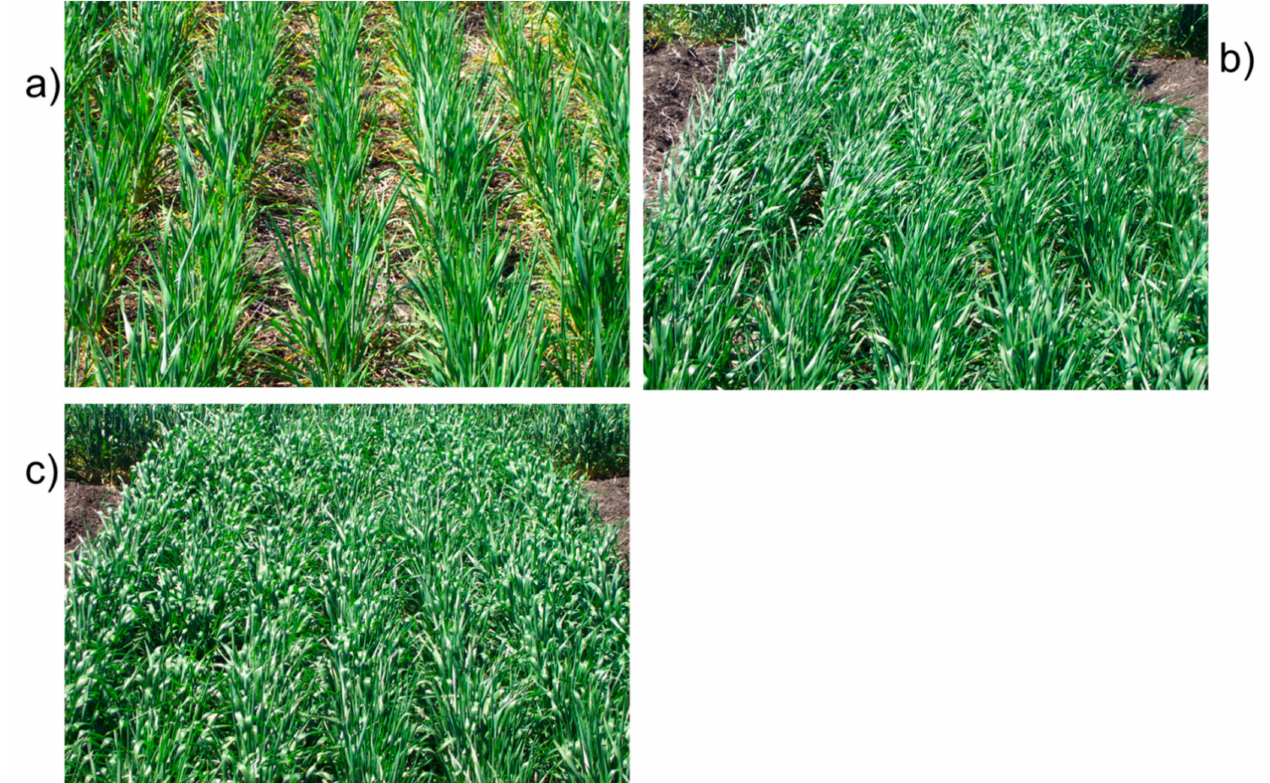
Figure 13. Appearance of wheat plots at Z35 late stem elongation ( a ) P. thornei -susceptible cv. Janz soil showing symptoms of lower leaf yellowing, poor canopy closure and low biomass, ( b ) cv. Janz growing on fumigated soil showing reduced, and ( c ) QT9050, a wheat line moderately resistant to P. thornei , showing no symptoms. Ratings of cultivars at late stem elongation(Z35) growing in untreated soil ranged from 2.2 for wheat cv. Strzelecki to 5.8 for barley cv. Binalong (Figure 14a). Other wheat